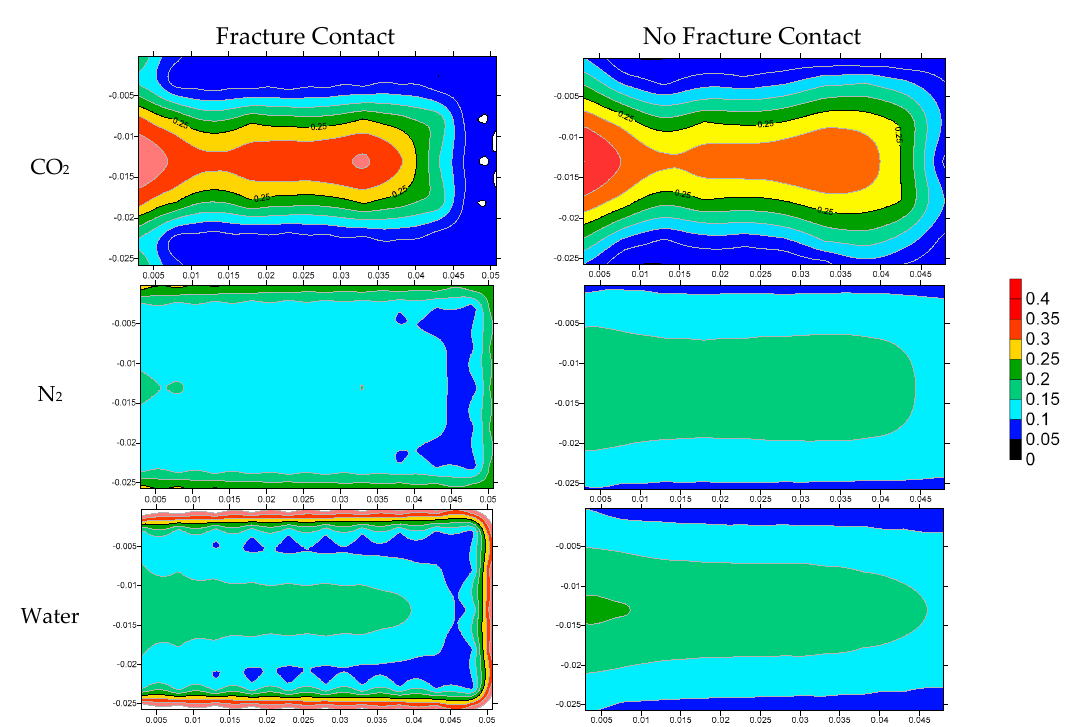
Energies 2019 , 12 , 823 17 of 29